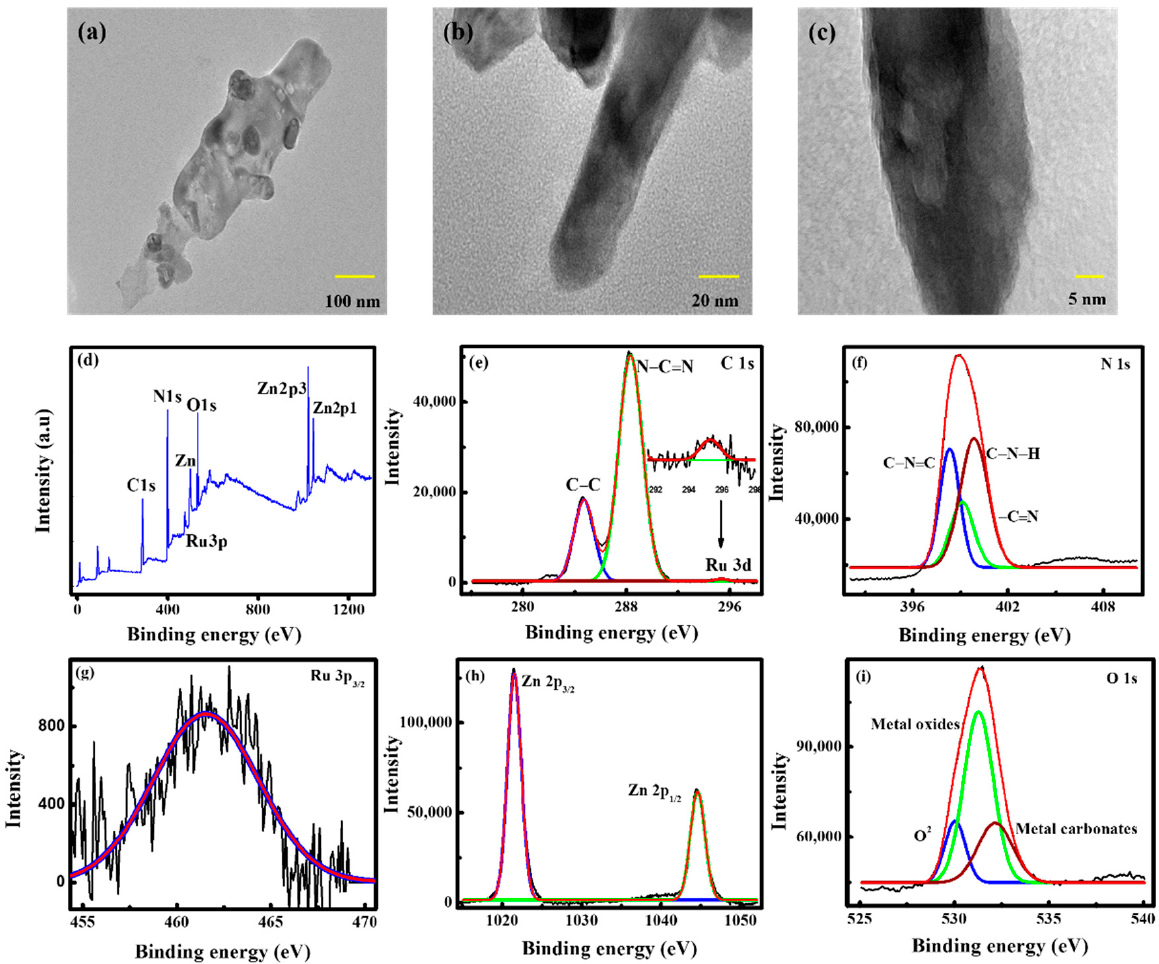
Figure 2. TEM images ( a – c ) and XPS spectrum ( d – i ) of ZnO–g–Ru–C 3 N 4 composite. Surveys scan ( d ), C 1 s ( e ), N 1 s ( f ), Ru ( g ), Zn 2P ( h ) and O 1 s ( i ).